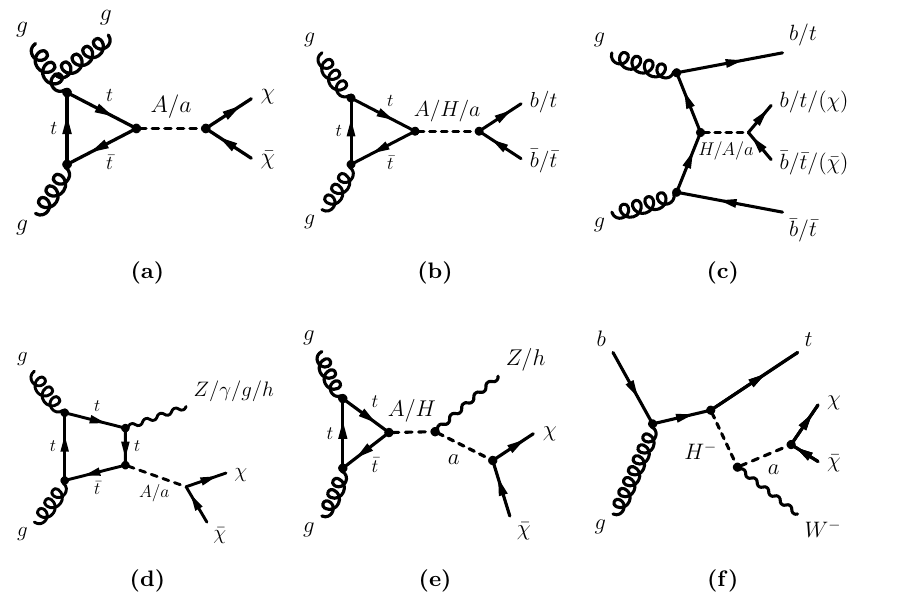
Figure 6. Schematic representation of the dominant production and decay modes for the 2HDM+ a model.